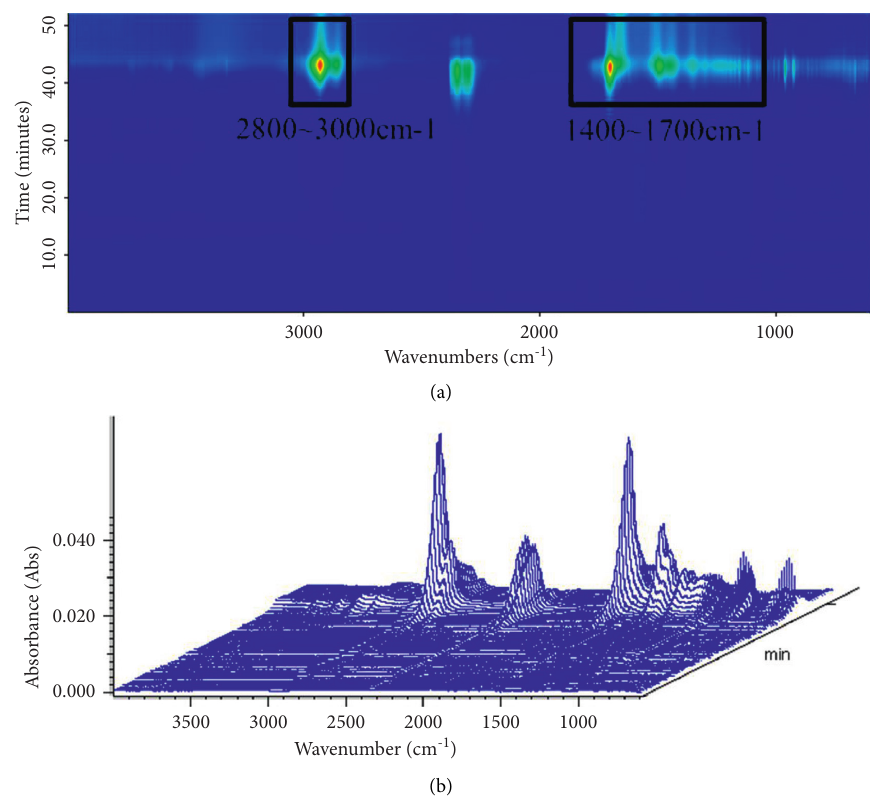
Figure 4: 2D and 3D spectrogram of the PA6